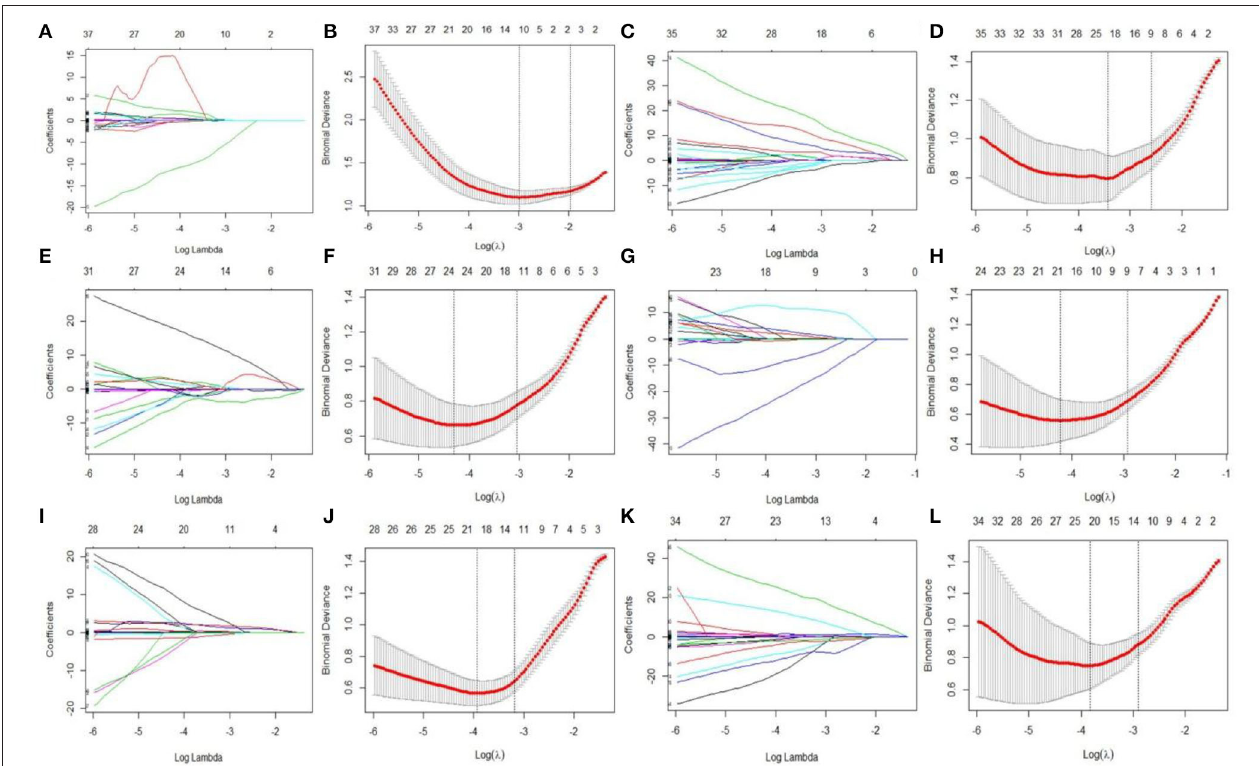
FIGURE 5 | Features dimensionality reduction with LASSO regression among four SPS groups. Each colored line represent coefficients of texture features, which plot vs. ln(lambda) in mPFC radiomics signatures between each SPS groups: (A) SPS 1d vs. SPS 4d; (C) SPS 1d vs. SPS 7d; (E) SPS 1d vs. SPS 14d; (G) SPS 4d vs. SPS 7d; (I) SPS 4d vs. SPS 14d; (K) SPS 7d vs. SPS 14d. The binomial deviances were plotted vs. ln(lambda) in mPFC radiomics signatures between each SPS groups: (B) SPS 1d vs. SPS 4d; (D) SPS 1d vs. SPS 7d; (F) SPS 1d vs. SPS 14d; (H) SPS 4d vs. SPS 7d; (J) SPS 4d vs. SPS 14d; (L) SPS 7d vs. SPS